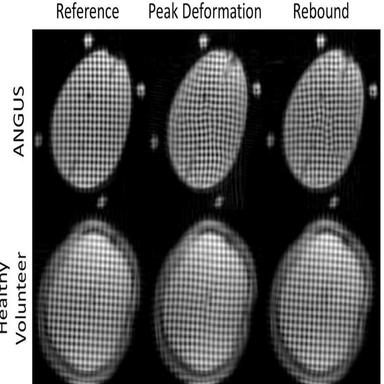
Tagged MRI data of the ANGUS phantom (top row) and a healthy volunteer (bottom row) at three time points during the neck rotation motion. The tag lines appear straight in the reference configuration (left column), are visibly deformed in both the phantom and healthy volunteer at the time of peak deformation (middle column), and then slightly rebound (right column) as the motion dampens.